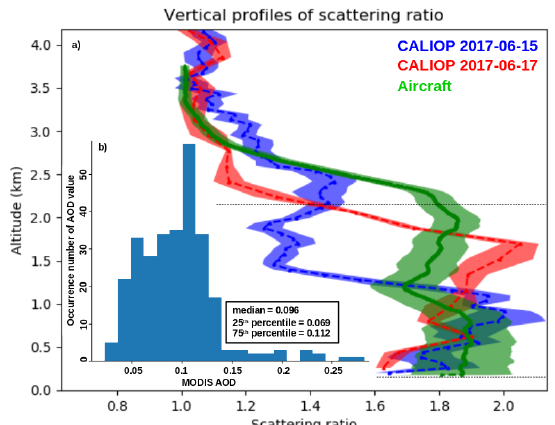
Fig. 5: (a) 50 km average of the backscatter ratio vertical profile for the airborne lidar on June 16 th 05 UT (green), CALIOP on June 15 th (blue) and on June 17 th (red). (b) MODIS AOD in the ± 70 km area around the aircraft.